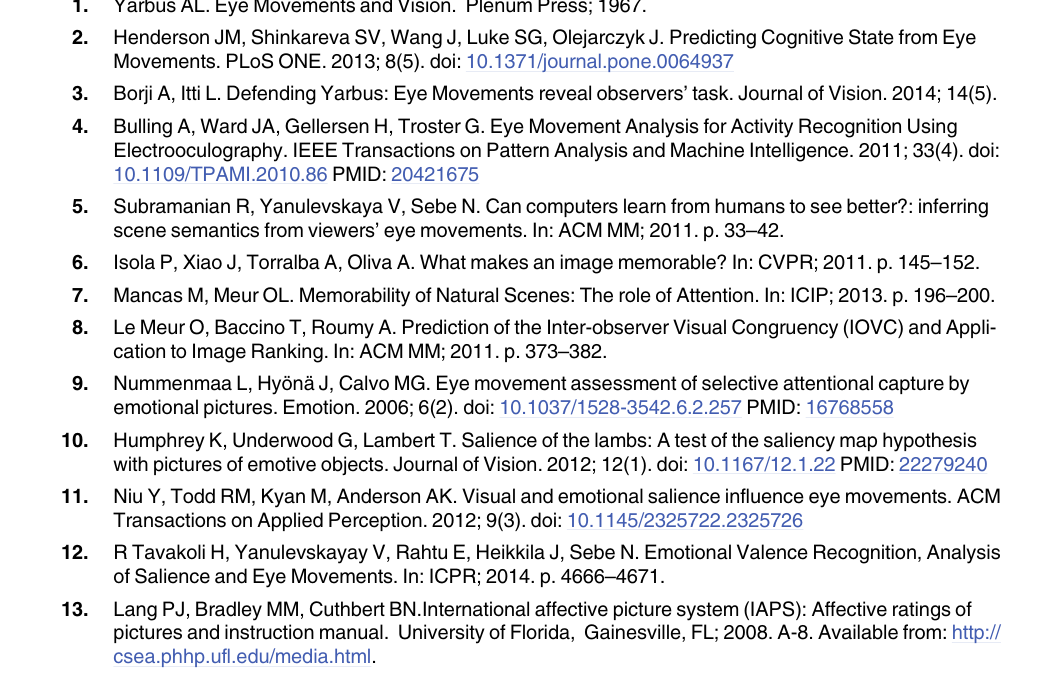
Table D in S1 File, confusion matrices: mean features and RBF SVM. Table E in S1 File, confu- sion matrices: mean features and polynomial SVM. Table F in S1 File, confusion matrices: mean features and linear SVM. Table G in S1 File, confusion matrices: individual features and RBF SVM. Table H in S1 File, confusion matrices: individual features and polynomial SVM. Table I in S1 File, confusion matrices: individual features and linear SVM. Table J in S1 File, confusion matrices: feature selection/decomposition and RBF SVM. Table K in S1 File, confu- sion matrices: feature selection/decomposition and polynomial SVM. Table L in S1 File, confu- sion matrices: feature selection/decomposition and linear